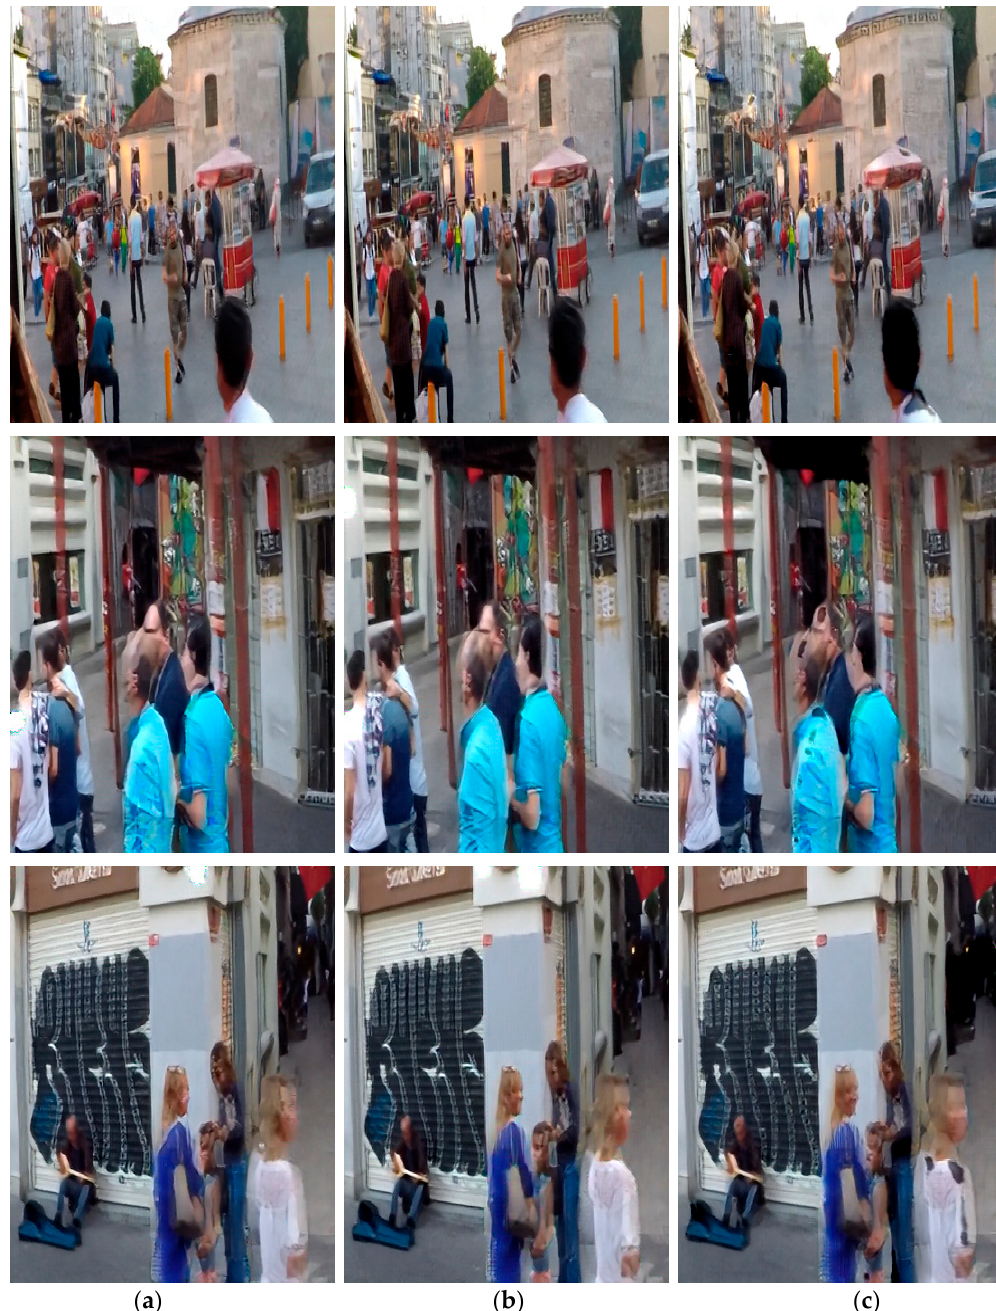
Figure 24. Generated object images according to different λ values: ( a ) λ =10 ( b ) λ =100 ( c ) λ =1000.